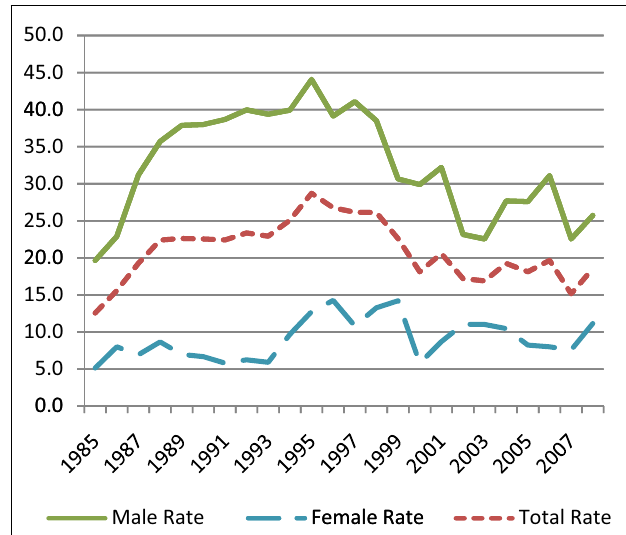
FIGURE 1 |Age-specific youth suicide rates by sex in New Zealand 1985–2008 . Source: Ministry of Health New Zealand Health.